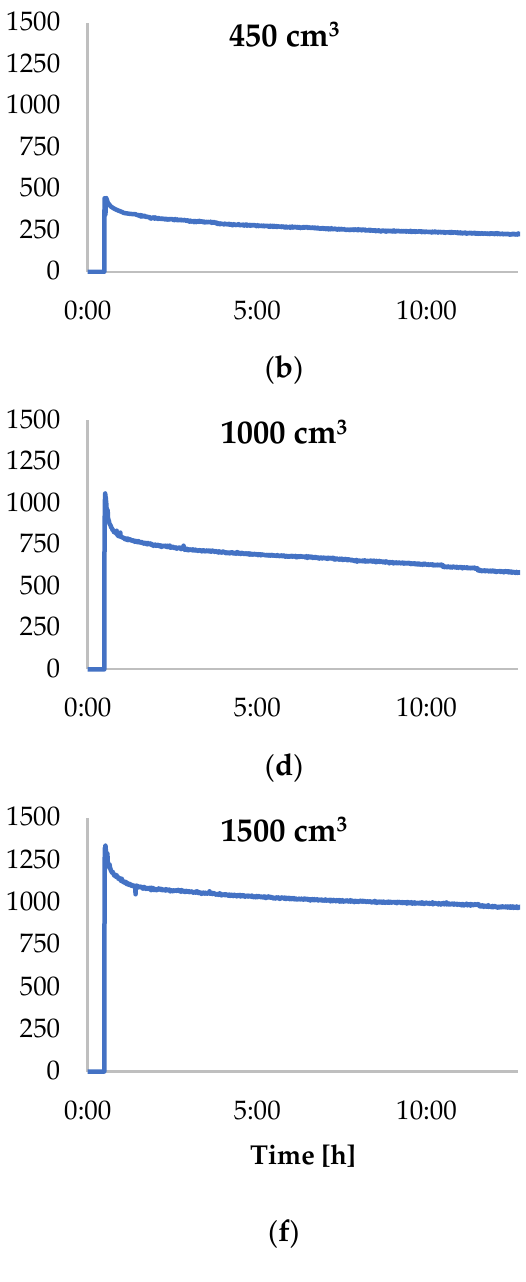
Figure 8. Changes of water content in sand monolith during the injection of 250 ( a ), 450 ( b ), 750 ( c ), 1000 ( d ), 1250 ( e ), and 1500 ( f ) cm 3 of water, in a 12-h time interval.